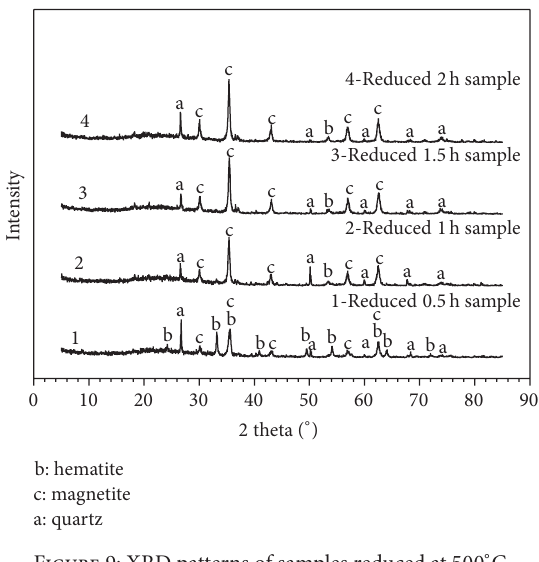
Figure 9: XRD patterns of samples reduced at 500 ∘ C.